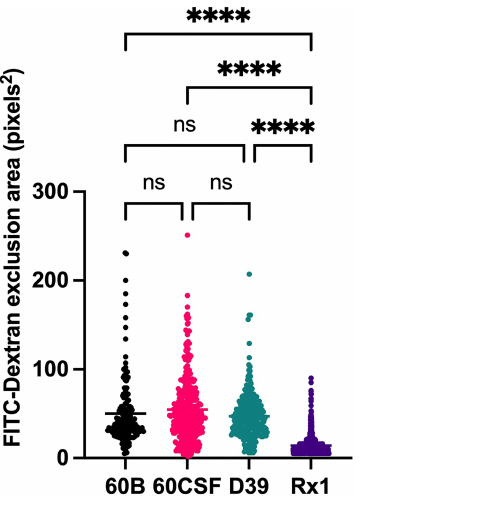
FIGURE 6 | Capsule area of blood and CSF isolates, measured using FITC-dextran exclusion assay. S. pneumoniae D39, Rx1, serotype 15C ST8711 blood isolate (60B) and CSF isolate (60CSF) were grown overnight before being resuspended to an OD 600 of 0.6 in 1 mL PBS. 80µL of bacterial suspension was added to 20µL FITC-dextran (10mg/mL in MilliQ water). A volume of 10 µL of the bacterial FITC-dextran suspension was pipetted onto microscope slides, fi xed with a coverslip, and imaged using a laser scanning microscope. Statistical analysis was performed using Kruskal-Wallis test; **** P < 0.0001. Imaging was conducted on 3 separate days with fresh bacterial suspensions prepared each time. ns, not signi fi cant.